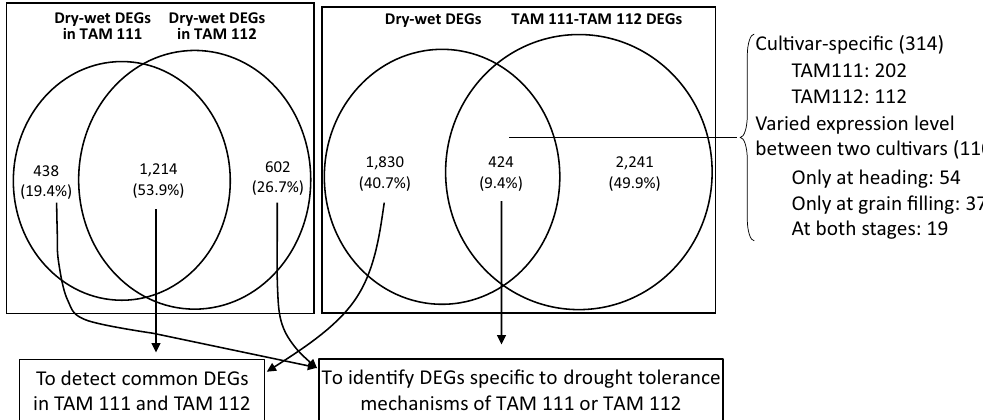
Figure 1. Differentially expressed genes (DEGs) revealed by expression comparison between dry and wet conditions in TAM 111 and TAM 112 and between TAM 111 and TAM 112 wheats under dry and wet